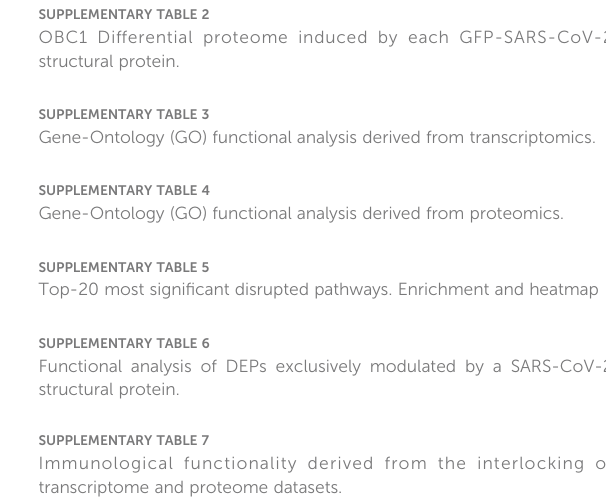
Top-20 most signi fi cant disrupted pathways. Enrichment and heatmap